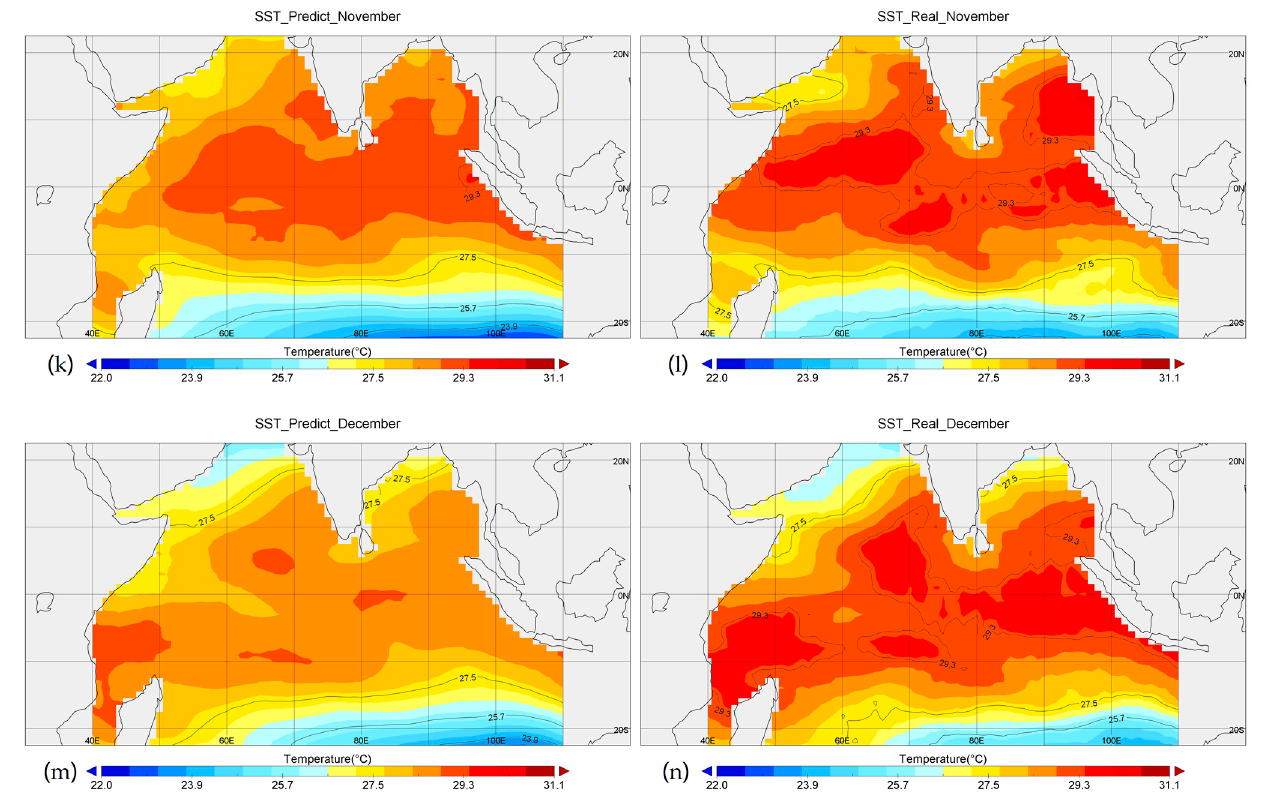
Figure 6. The heat map of the convLSTM model from June 2015 to December 2015 with wind field data and real heat map. ( a , c , e , g , i , k , m ) respectively show the sea surface temperature predicted by the convLSTM model with wind field information, and ( b , d , f , h , j , l , n ) respectively show the real sea surface temperature from June to December .